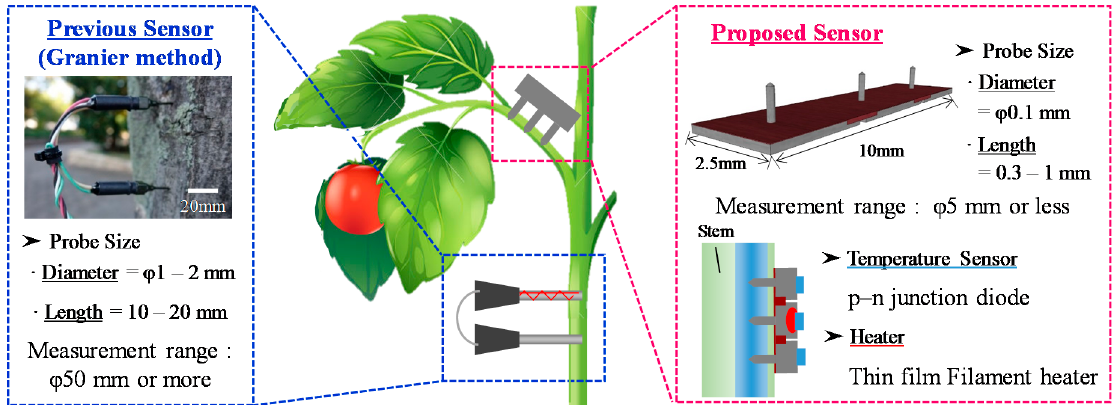
Figure 1. Comparison of the proposed and previous